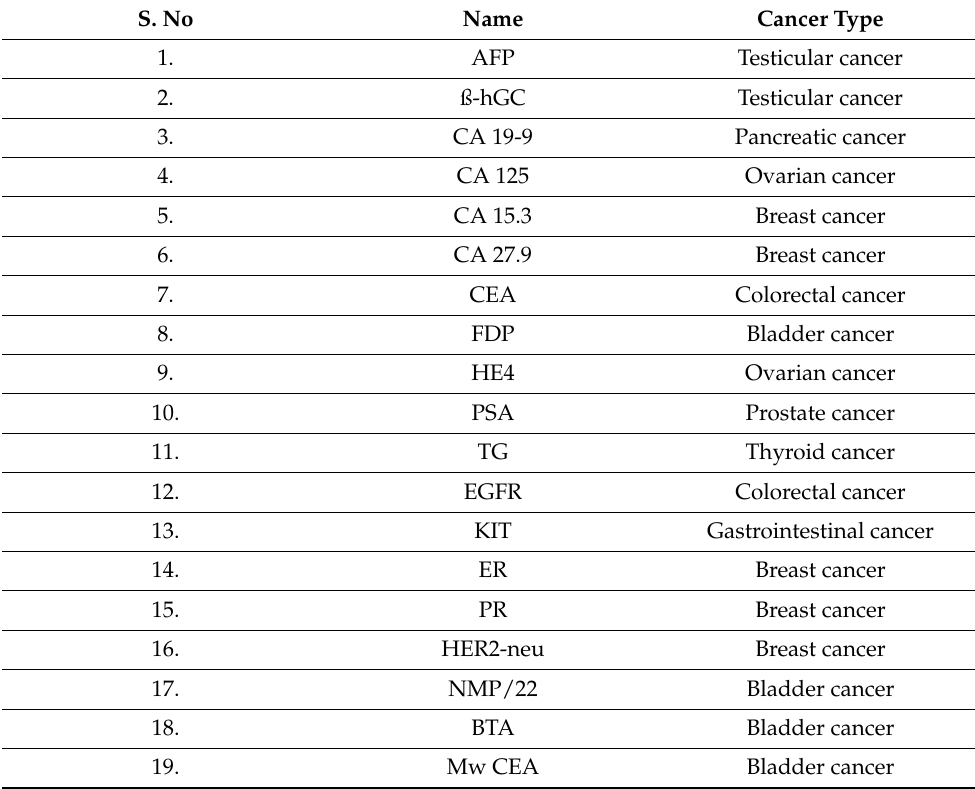
Table 1. List of protein biomarkers along with its related cancer type.